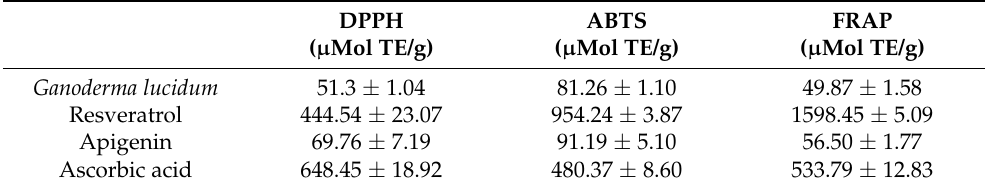
Table 3. Antioxidant activity in a methanolic extract of Ganoderma lucidum and authentic standards of resveratrol, apigenin, and ascorbic acid.